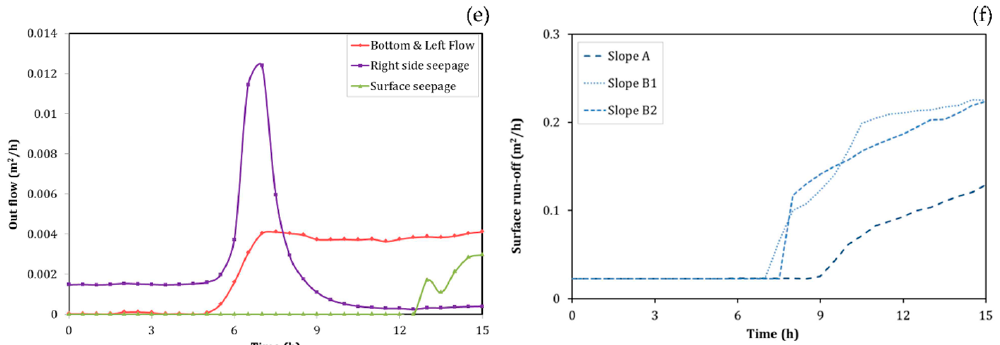
Figure 10. ( a ) Definition of boundaries of the control domain, ( b ) net infiltration rate into slope A, B1, and B2, ( c ) outflow at different boundaries of the control area of slope A, ( d ) outflow at different boundaries of the control area of slope B1, ( e ) outflow at different boundaries of the control area of slope B2, ( f ) surface run off of slope A, B1, and B2 as a function of time for the 15-h rainfall event with an intensity of 20 mm per hour.